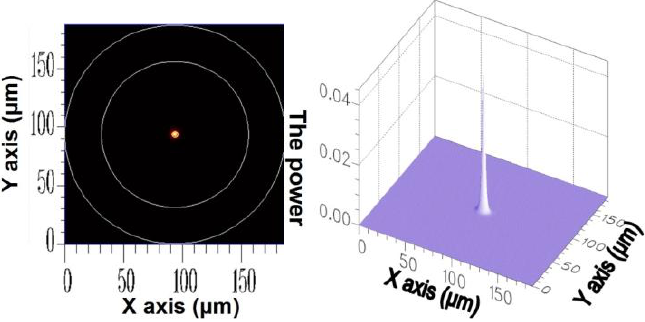
Figure 2. The 2D and 3D power diagram of HE 451975.1  core n eff